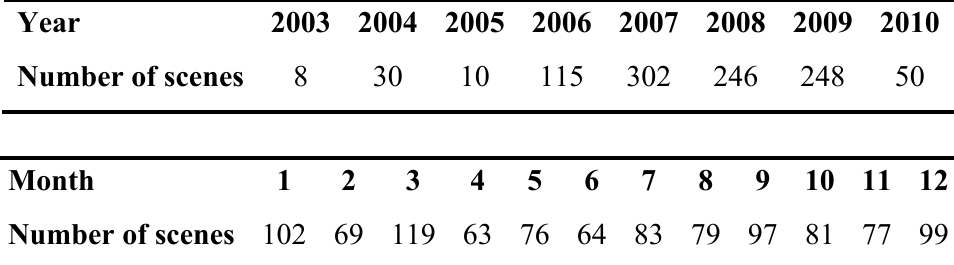
Table 1. Envisat ASAR data used in the study per year and per